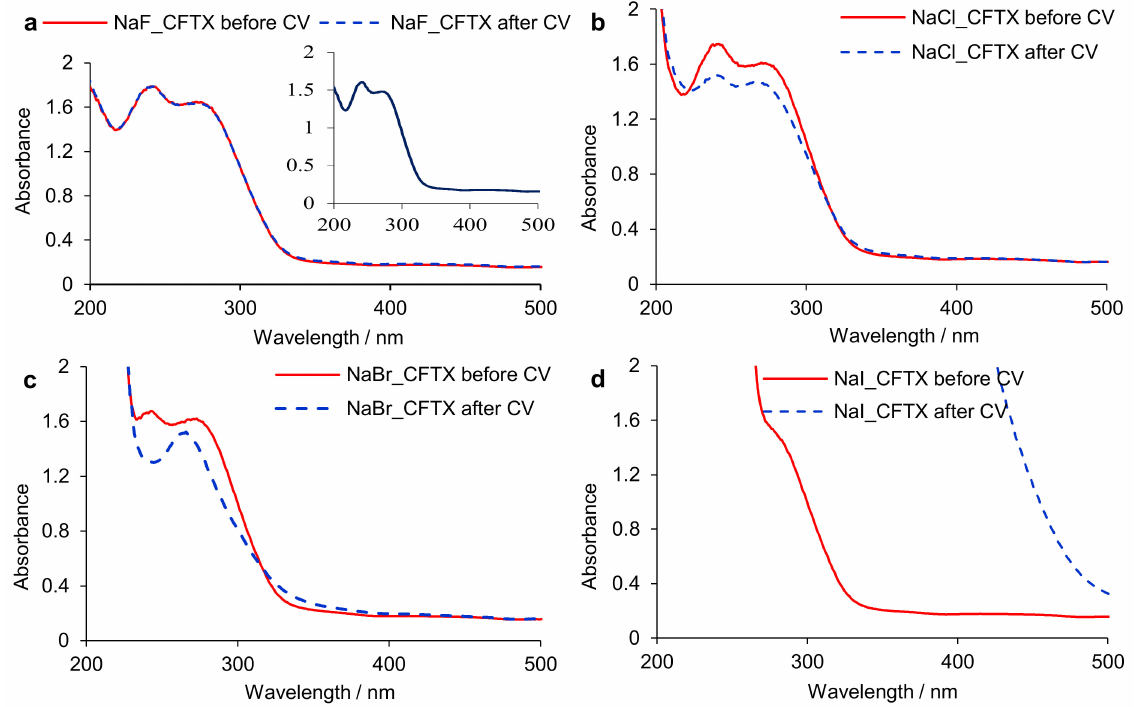
Figure 2. CFTX UV-Vis spectra recorded before and after cyclic voltammetry (CV): ( a ) CFTX/sodium fluoride solution; ( b ) CFTX/sodium chloride solution; ( c ) CFTX/sodium bromide solution; ( d ) CFTX/sodium iodide